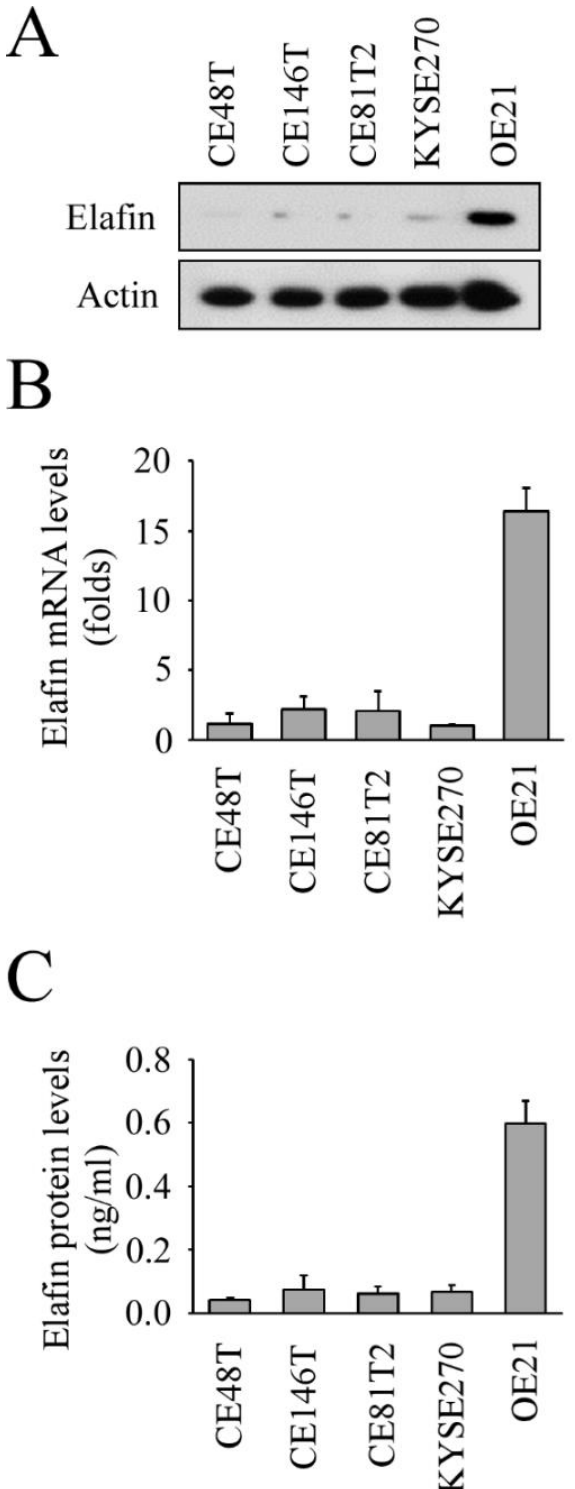
Figure 2. Expression and secretion of elafin in different esophageal squamous cell carcinoma cell lines: ( A ) the expression of elafin protein; ( B ) elafin mRNA expression levels; ( C ) the expression of elafin protein in cultured medium.